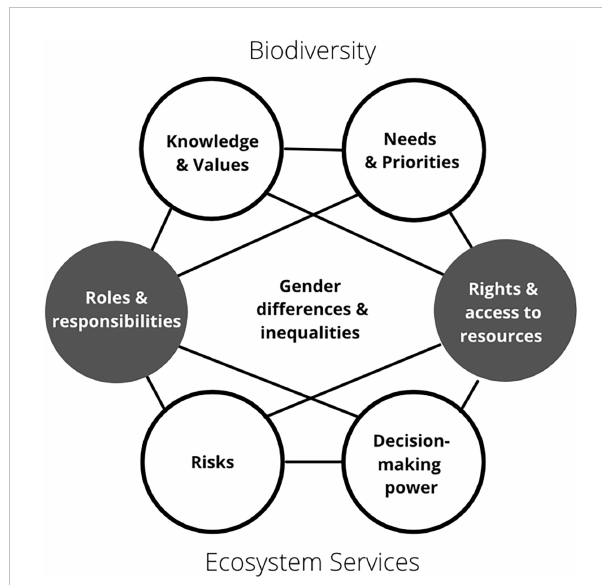
FIGURE 1 Gendered determinants of biodiversity conservation and ecosystem services based on the framework of the Convention on Biodiversity (Secretariat of the Convention on Biological Diversity, 2019). Gender differences and inequalities in roles and rights are shown as key determinants (dark gray) of biodiversity conservation and ecosystem services. These determinants are inter-related with other determinants: knowledge/values, needs/priorities, risk, and decision- making power (light